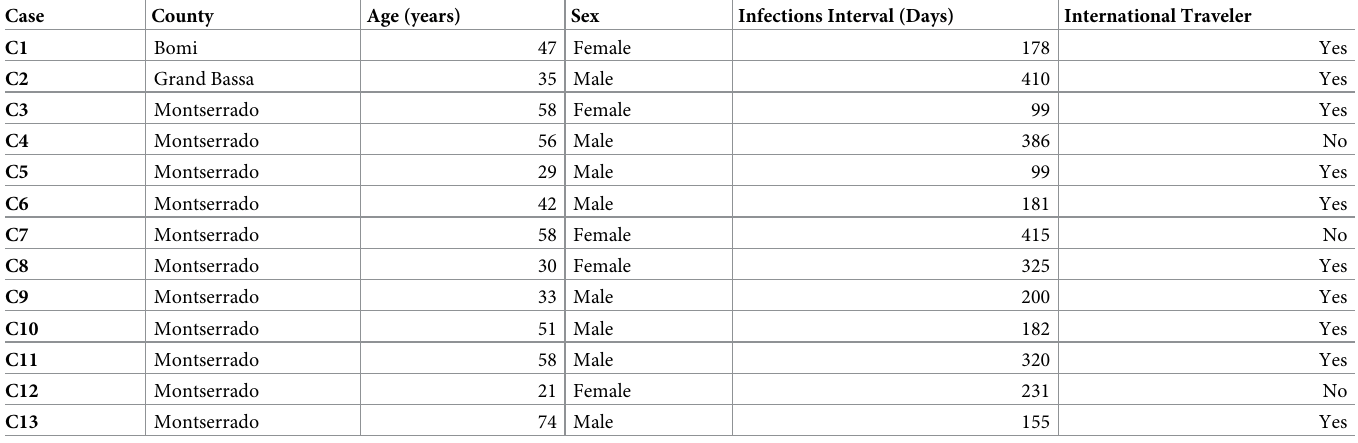
Table 1. The distribution of COVID-19 reinfection cases in Liberia, March 2020 –July